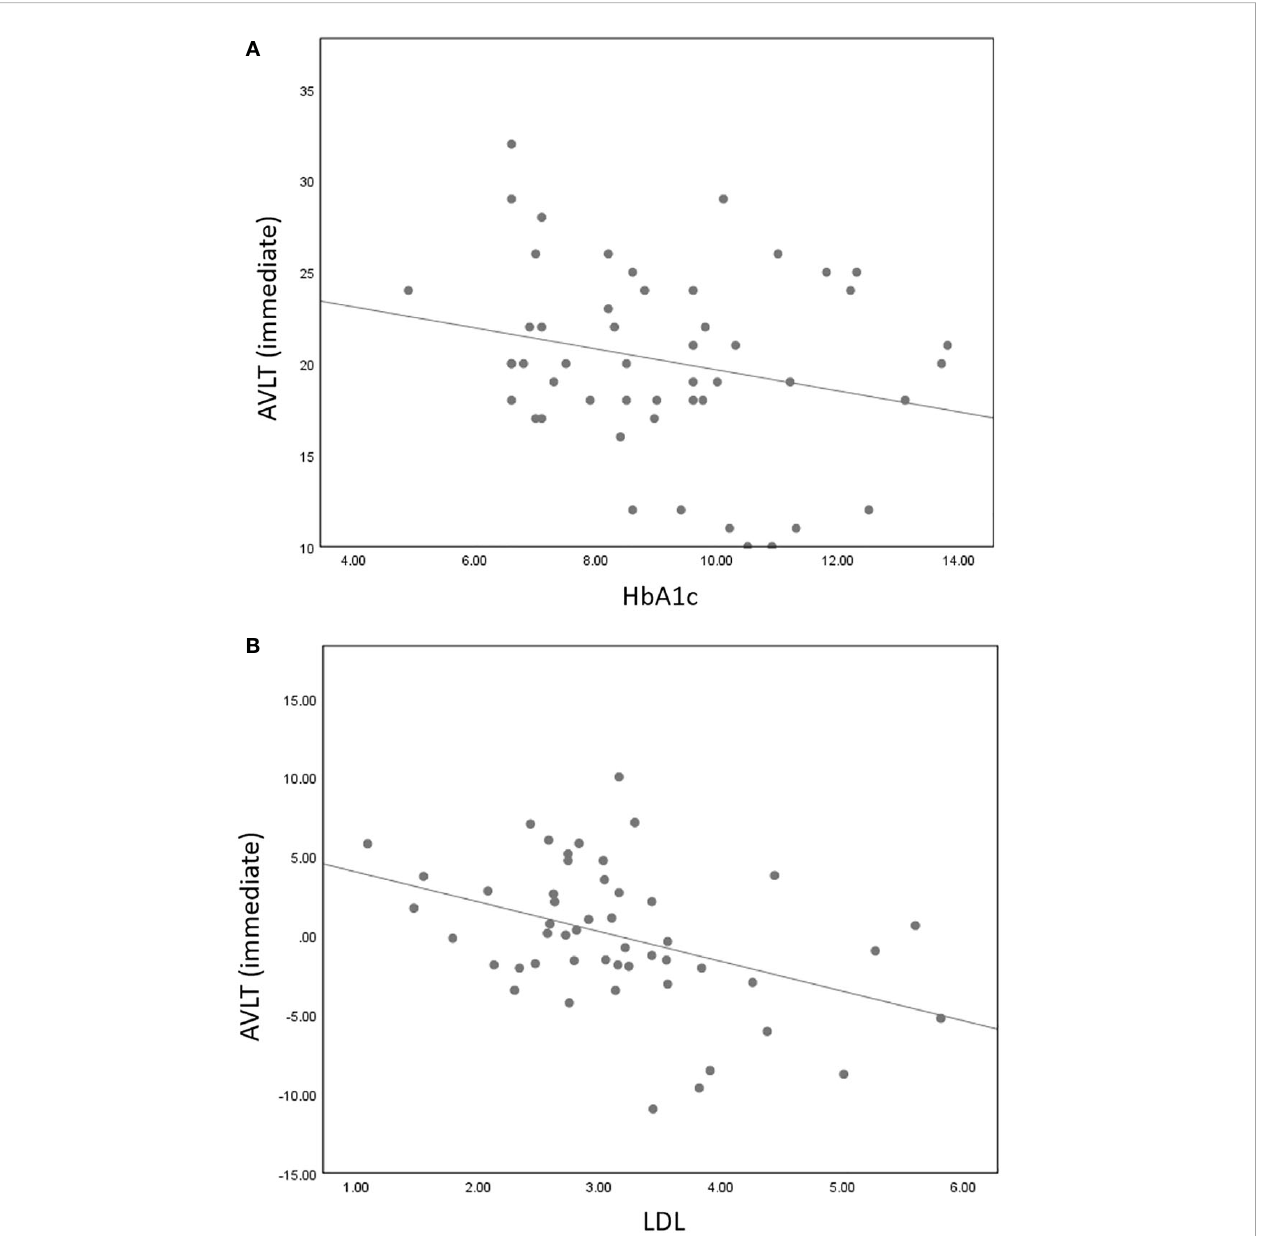
FIGURE 5 AVLT immediate memory scores were negatively correlated with HbA1c (r = -0.309, P = 0.035) (A) and LDL (r = -0.399, P = 0.004) (B)